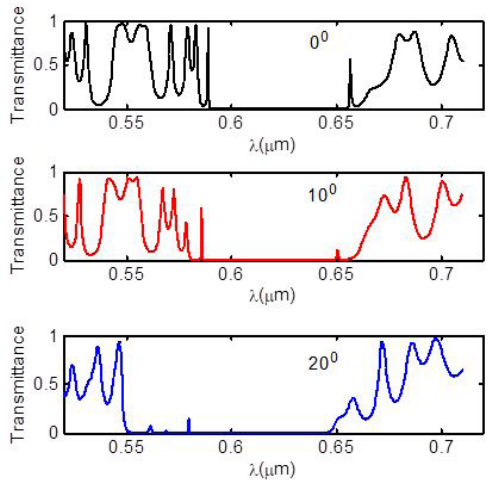
Figure 7. Transmittance spectra for quasi-periodic 1DPC at a different incident angle with fixing another parameter at d2=0.1µm, d3=0.08µm, and T=100K